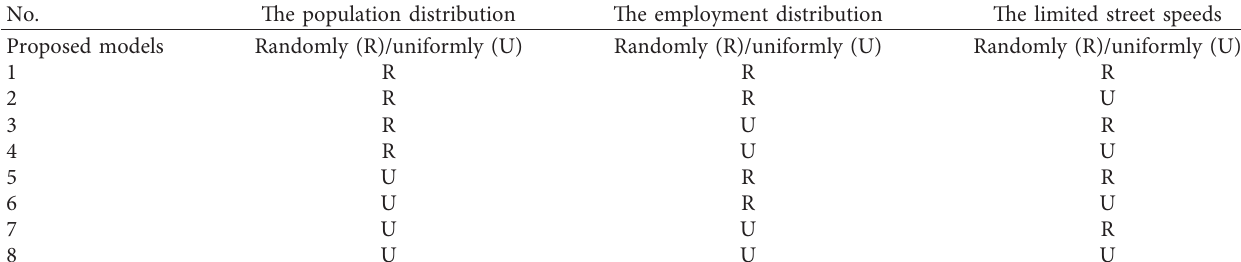
Table 1: The simulation scenarios.